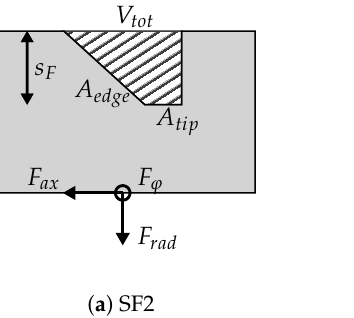
Figure 9. Participating contact areas A edge , A tip ; measured force components F ϕ , F rad ; and total wear volume V tot